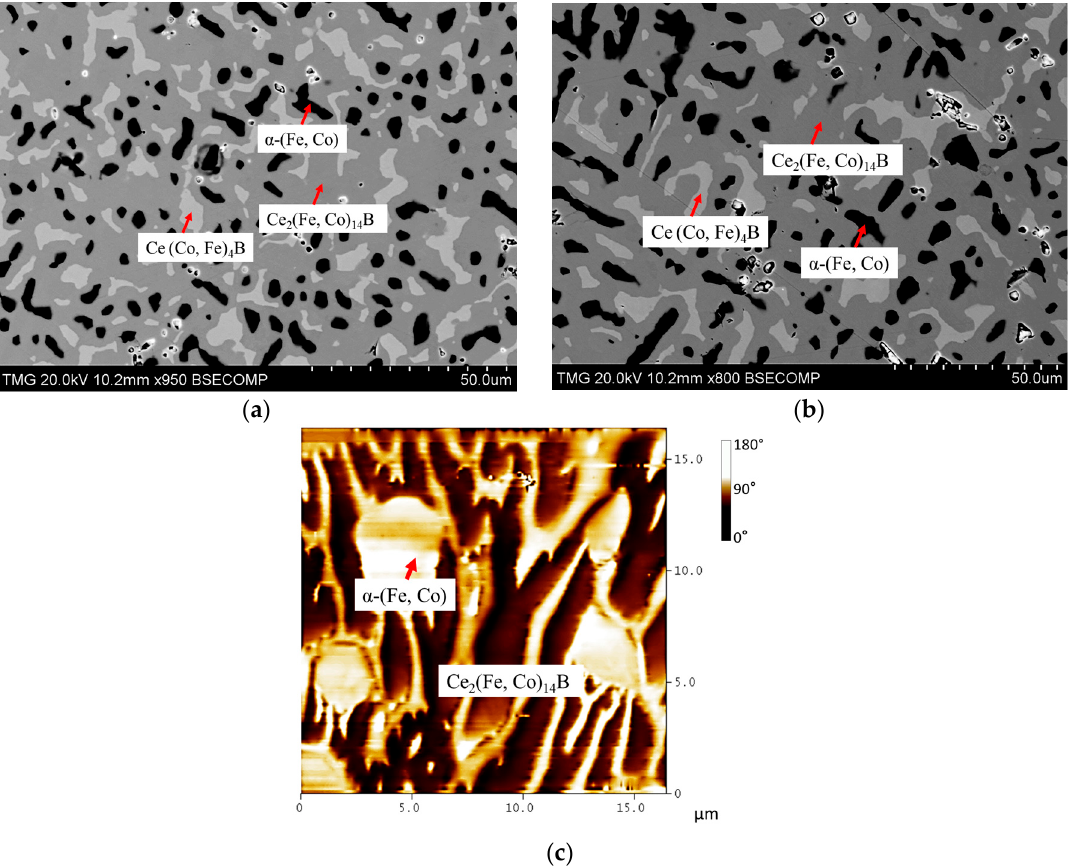
Figure 14. ( a ) BSE image of KA 4; ( b ) BSE image of KA 5; ( c ) MFM image of KA 5.